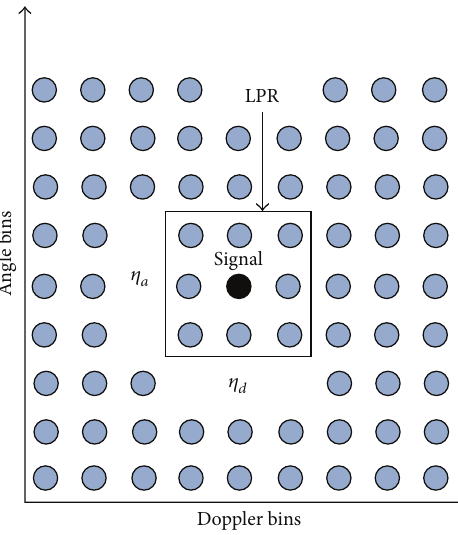
Figure 2: Localized processing region in